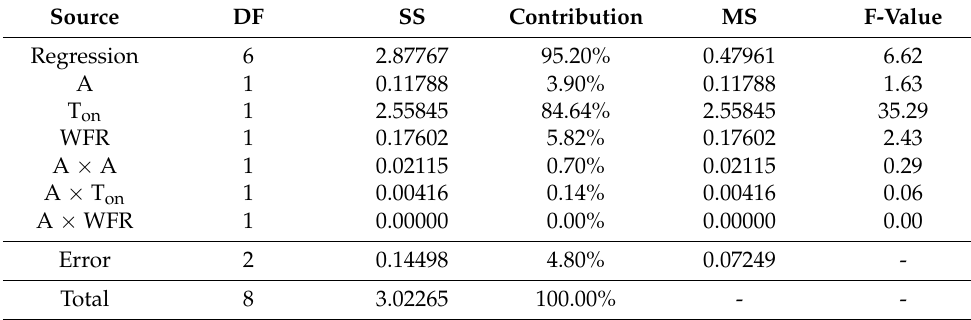
Table 2. Analysis of variance: surface roughness—Al6351–5% SiC–0% B 4 C.